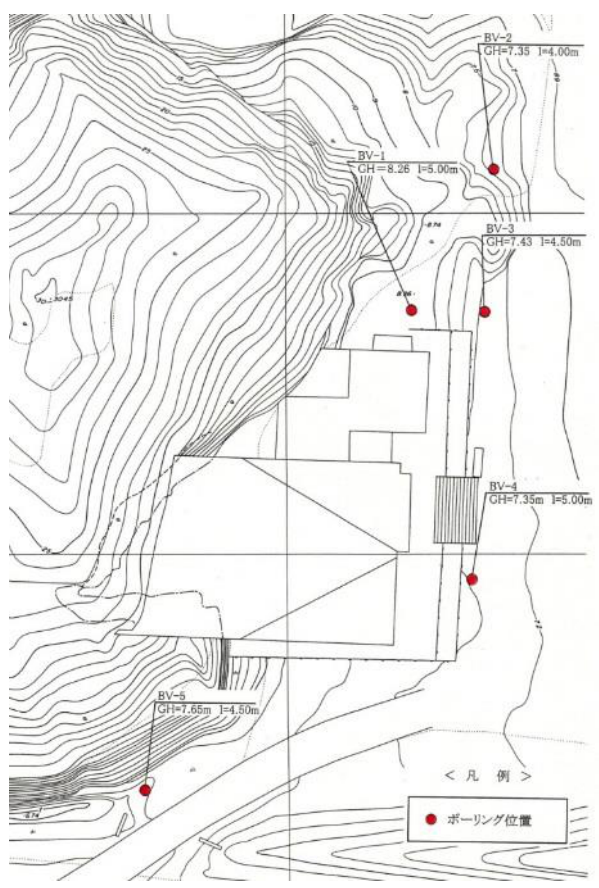
Figure 6. Bore locations (red